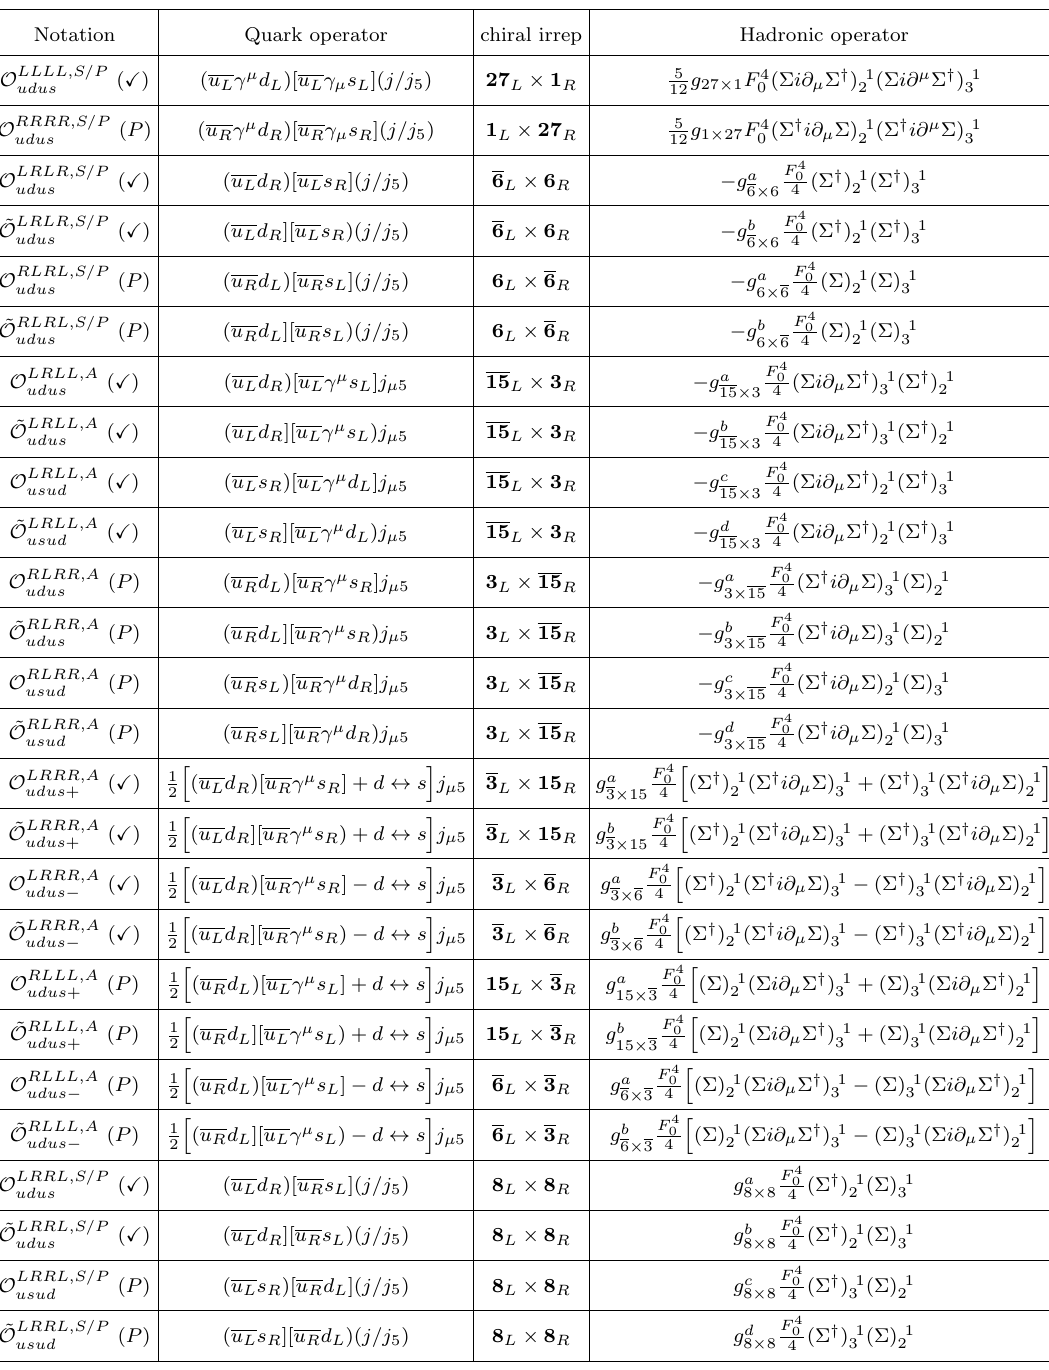
Table 3 . Quark factors of dim-9 operators in LEFT are matched at the leading nonvanishing order to their hadronic counterparts in (cid:31) PT that are relevant to K (cid:0) ! (cid:25) + l (cid:0) l (cid:0) . Nonvanishing lepton bilinears j = ( ll C ) ; j 5 = ( l(cid:13) 5 l C ) ; j (cid:22) 5 = ( l(cid:13) (cid:22) (cid:13) 5 l C ) for an identical lepton pair l = e; (cid:22) are not shown in hadronic factors for